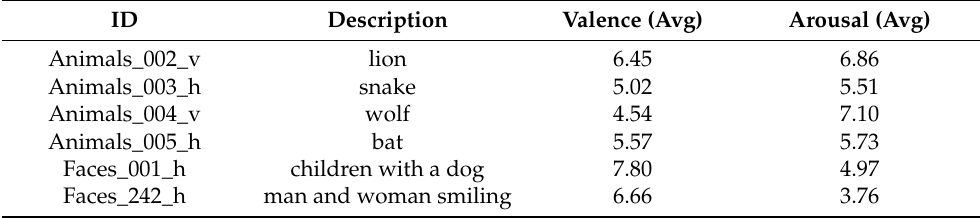
Table 1. An extract of the sub sample of the NAPS dataset annotations used in the experiment.